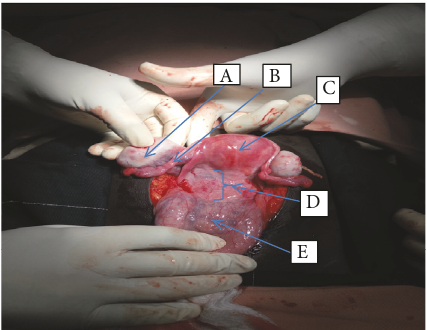
Figure 2: The arrows in the above picturetaken intraoperativeshow the right ovary (A), the right fallopian tube (B), uterus (C), vaginal wall mass pushed up, (D) and bladder